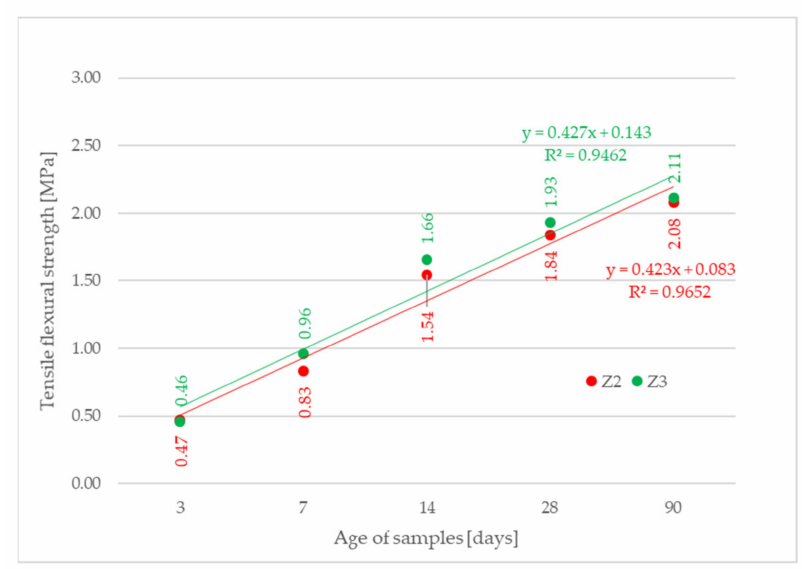
Figure 4. Tensile flexural strength of mixtures Z2 and